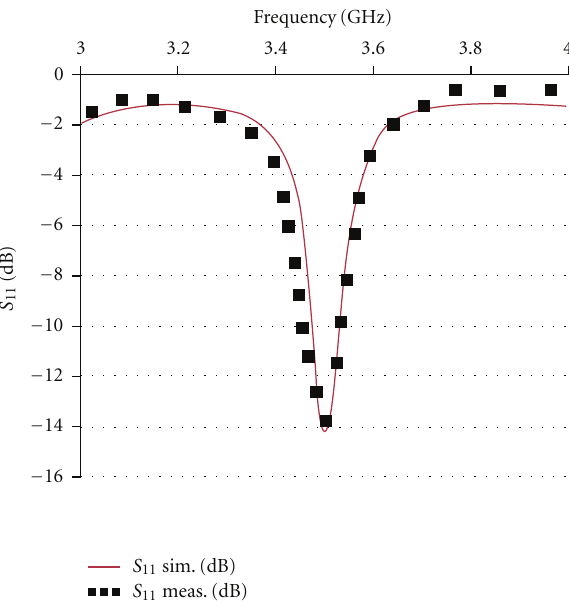
Figure 3: S 11 parameter for simulated and fabricated antenna.